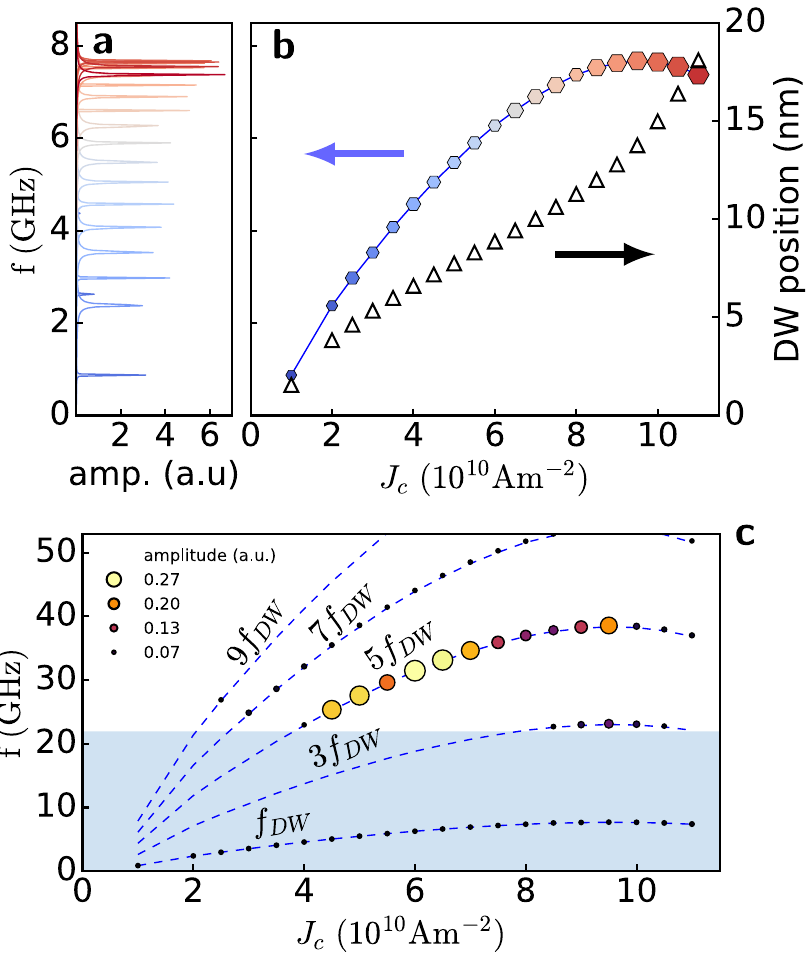
Figure 4. Frequency study of DW rotation and SW emission. ( a) Frequency spectra of 〈 〉 m showing the peaks x from which f DW is extracted. ( b) DW frequency (full hexagons) as a function of applied current extracted from the peaks in ( a ) the size of the hexagons is proportional to the height of the peaks. Average DW position in the pinned rotation regime for the corresponding current (triangles). ( c) Principal peaks in the frequency spectrum extracted from region R away from the DW.The peak amplitude is denoted by the circle size and the colour scale, (dark to bright). The dashed lines denote f DW as in ( b ) and its odd multiples. The shaded region denotes the non-propagating frequency gap < f f 0